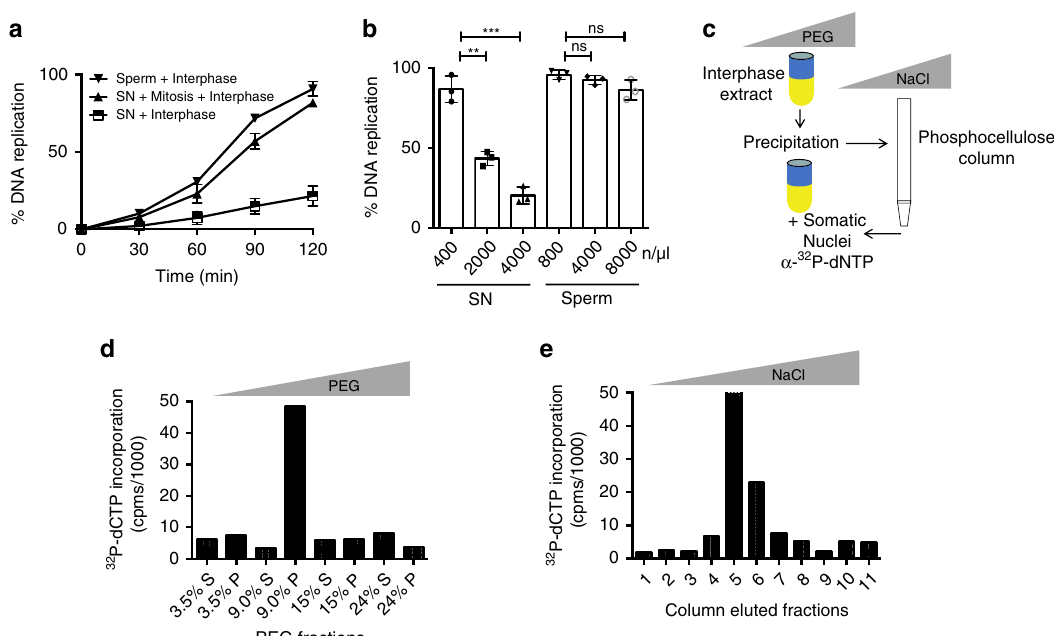
Fig. 1 Isolation of SSRP1 as somatic nuclei replication stimulating factor. a Graph showing DNA replication kinetics of sperm (8000 n/ μ l) or somatic nuclei (SN) (4000 n/ μ l). DNA was directly incubated in interphase egg extract (Interphase) or exposed for 30 min to CSF-arrested mitotic extract, which was then driven into interphase by 0.4 mM CaCl 2 addition (Mitosis + Interphase). DNA synthesis was quanti fi ed by measuring the percentage of α - 32 P-dCTP incorporation relative to the input DNA for each condition. Each point represents the mean value ± standard error of the mean (SEM). n = 3 independent experiments; p < 0.0001 when comparing mean values for all points; Two-way anova. b Graph showing DNA replication of the indicated amounts of sperm and SN directly incubated in interphase egg extract for 120 min. DNA synthesis was quanti fi ed as in ( a ). Bars represent mean ± SEM. n = 3 independent experiments; ** p < 0.01, *** p < 0.001 or ns when comparing mean values for the indicated samples; unpaired t test. c Schematic representation of Xenopus egg extract fractionation. Extract was precipitated by centrifugation following incubation with increasing amount of polyethylene glycol (PEG). Either pellet (P) or supernatant (S) fractions collected at different PEG concentrations were assayed for their ability to stimulate replication when incubated with SN then transferred to interphase extracts in the presence of radiolabelled nucleotide. d Graph showing α - 32 P-dCTP incorporation (counts per minute, cpms) in SN pre-incubated with the indicated PEG fractions for 30 min and then transferred to interphase egg extract for 120 min. e Graph showing α - 32 P-dCTP incorporation in somatic nuclei pre-incubated with the fractions eluted from the column as described in ( c ) loaded with the active PEG fraction (9%P) and then transferred to interphase egg extract for 120